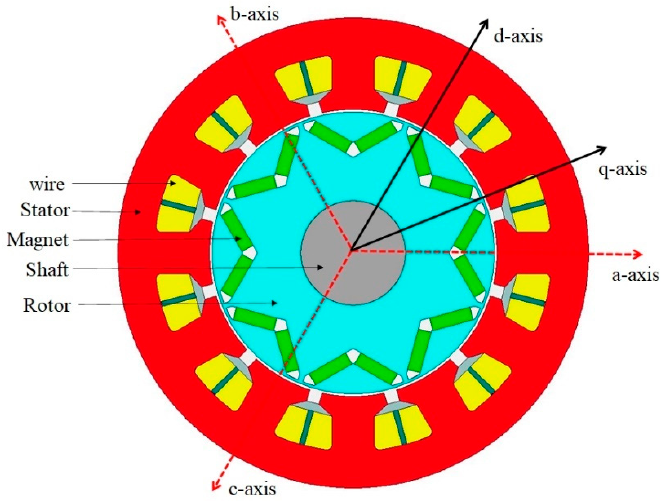
Figure 2. The three-phase V-shaped IPMSM with eight poles of magnets d - and q -axis definition.